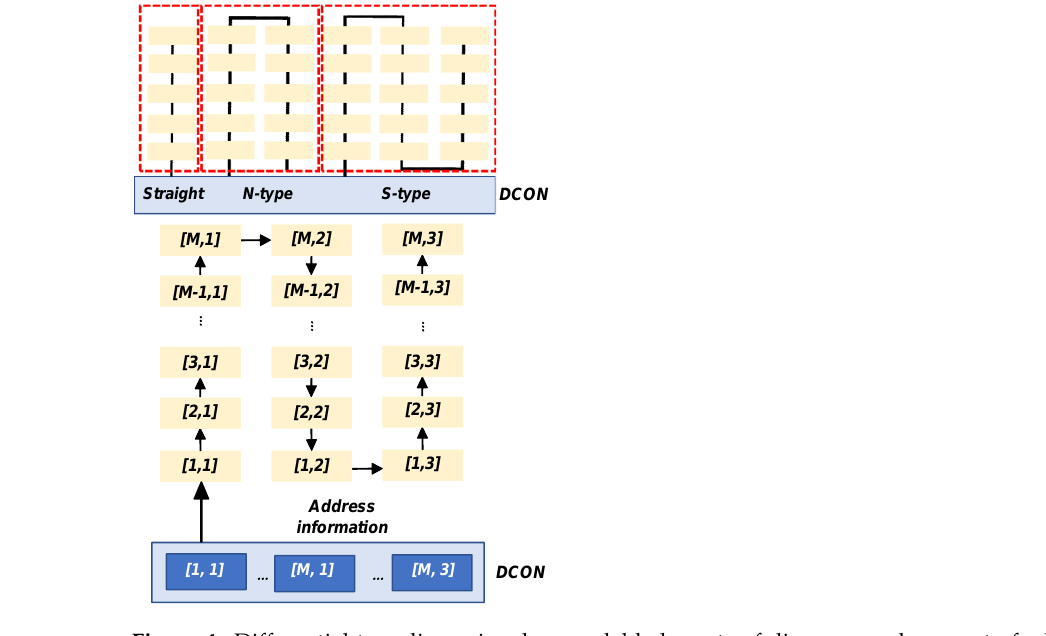
Figure 4. Differential two-dimensional expandable layouts of dimmers and concept of adaptive addressing method.